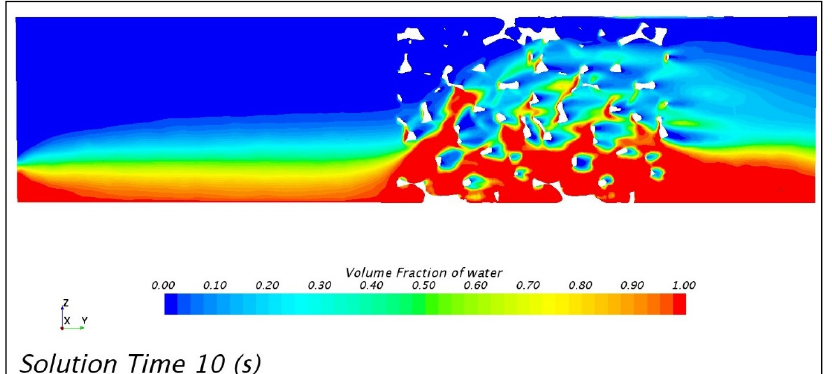
Figure 12. Distribution of liquid phase along the length of the channel containing foam layer.